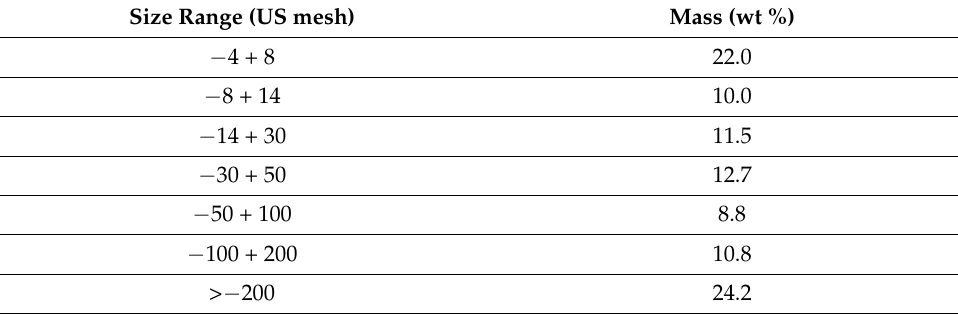
Table 1. Size distribution of coke aggregates in anode samples